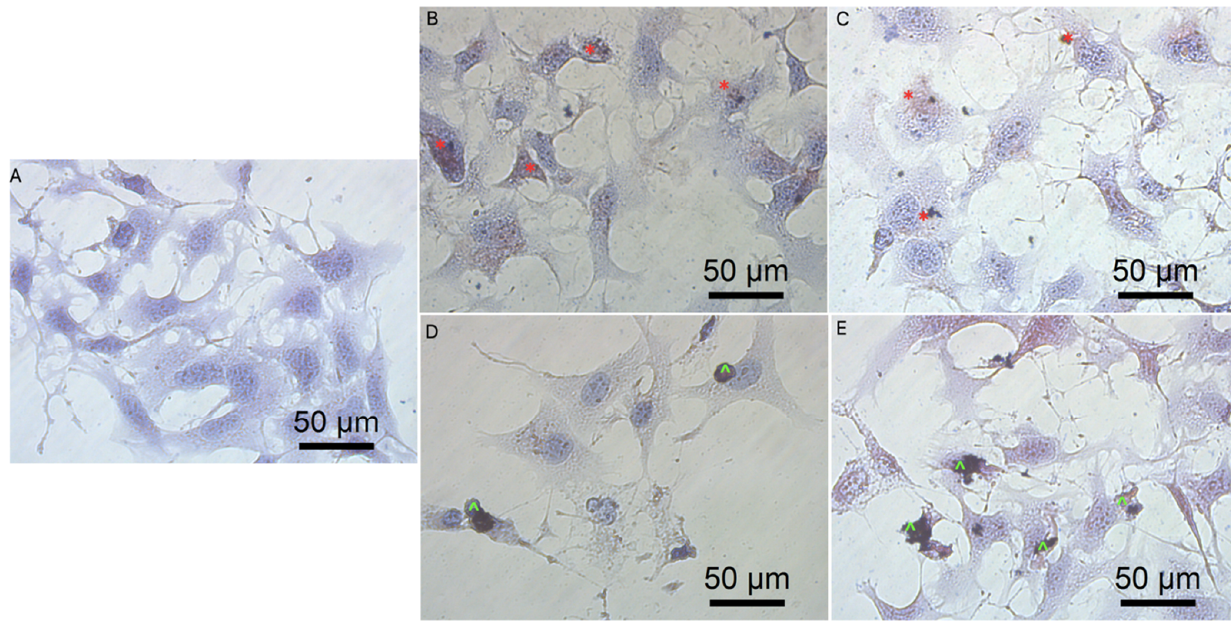
Figure 7. Morphology of U251 glioblastoma cells. ( A ) untreated cells (control group), cells treated with graphene oxide at concentration: 5 µ g/mL ( B ), 100 µ g/mL ( C ), and reduced graphene oxide at concentration: 5 µ g/mL ( D ) and 100 µ g/mL ( E ). Red * GO at cell membrane. Green ˆ rGO at cell membrane. Light optical microscopy. Scale bars: 50 µ m. ( A – E ). Abbreviations: GO: graphene oxide, rGO: reduced graphene oxide.